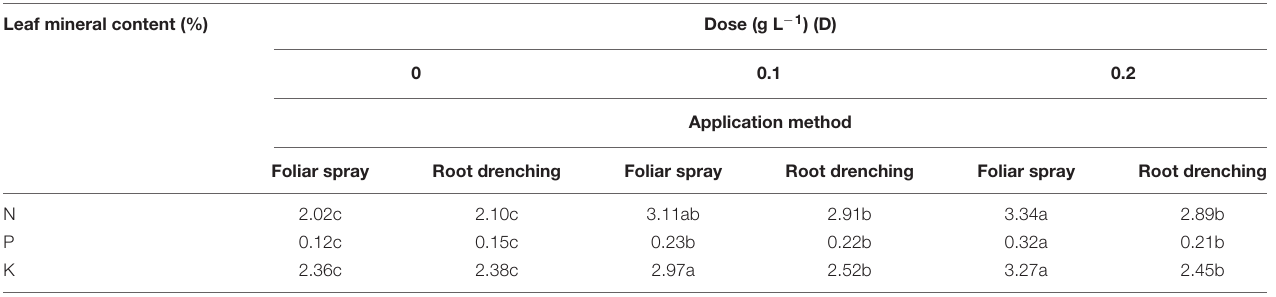
TABLE 5 | Dose × method interaction of animal-derived PH biostimulant on N, P, and K leaf total content in petunia plants for doses D0, D0.1, and D0.2 and foliar spray and root drench application methods. Leaf mineral content (%)